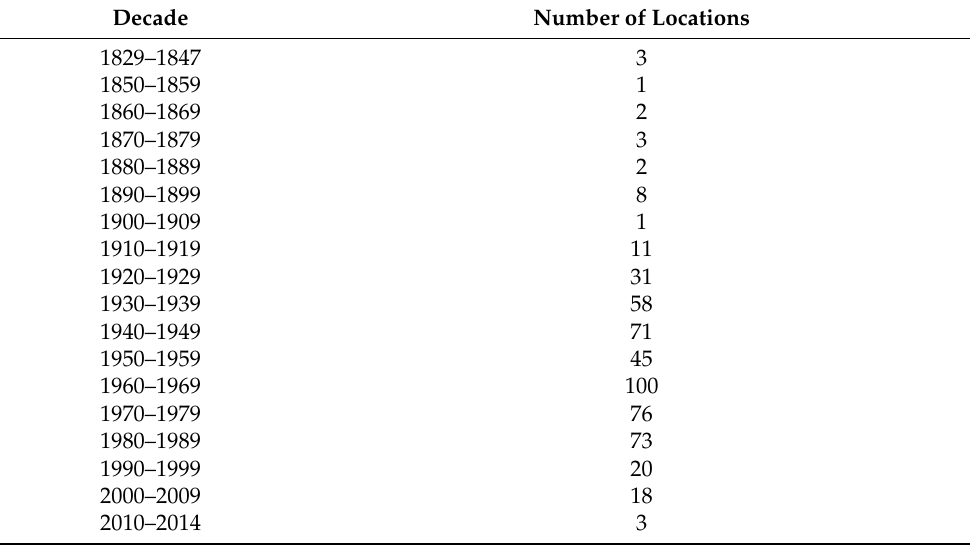
Table 1. Temporal changes in the number of occurrence locations, expressed as a function of the decade.